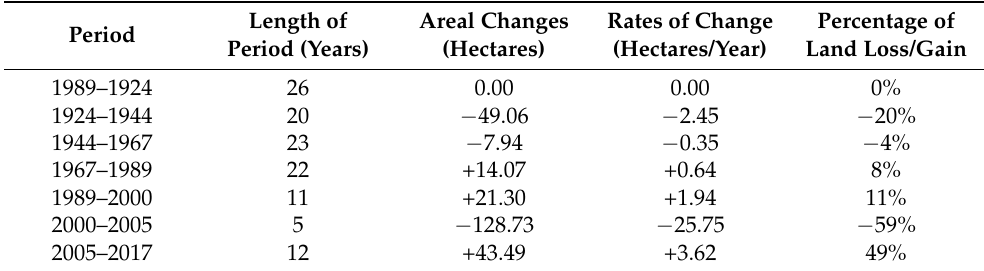
Table 4. Average long-term historical rates of land area change for both coasts for selected periods at Kuala Gigieng coast. Rates are in hectares/year. Positive numbers indicate land gain and negative numbers indicate land